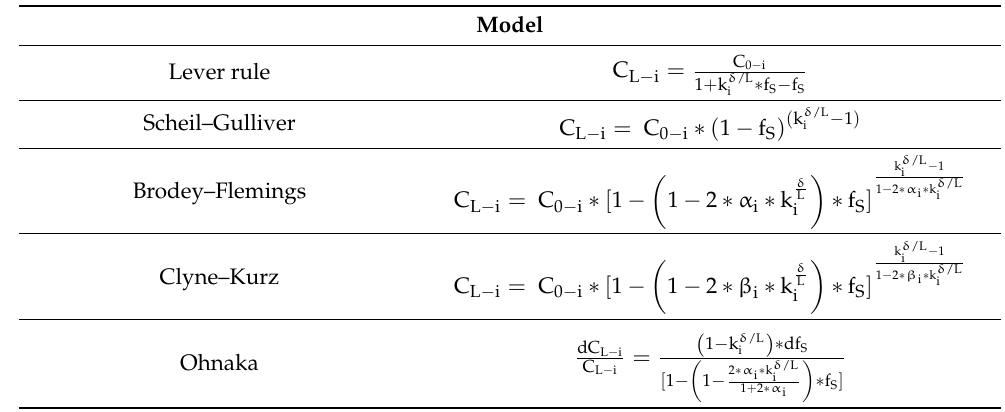
Table 7. Models for microsegregation predictions [15,18].